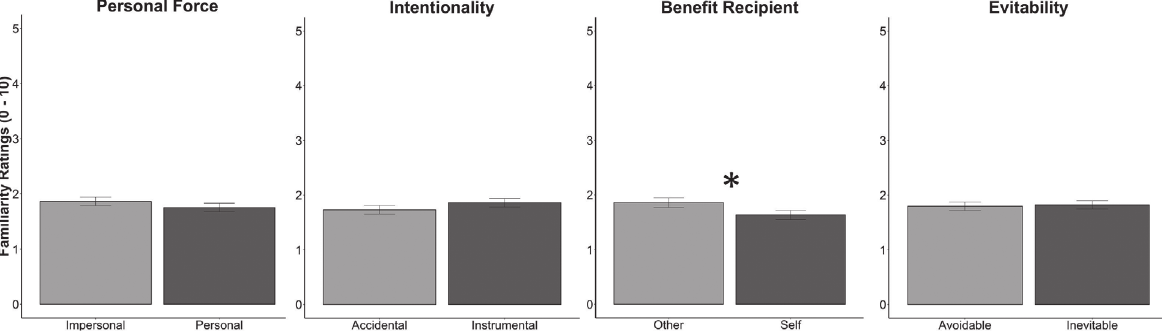
Figure 3. Familiarity ratings distribution per conceptual factors. Error bars represent CI of LMM model. Significant differences ( P < 0.05) are indicated via *.